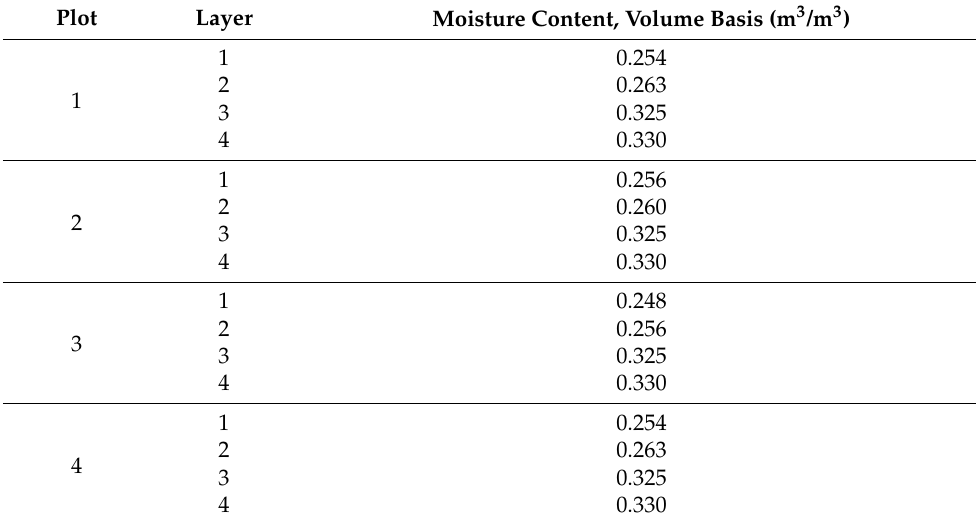
Table 5. Initial moisture content of different soil layers used as input in validating the model.